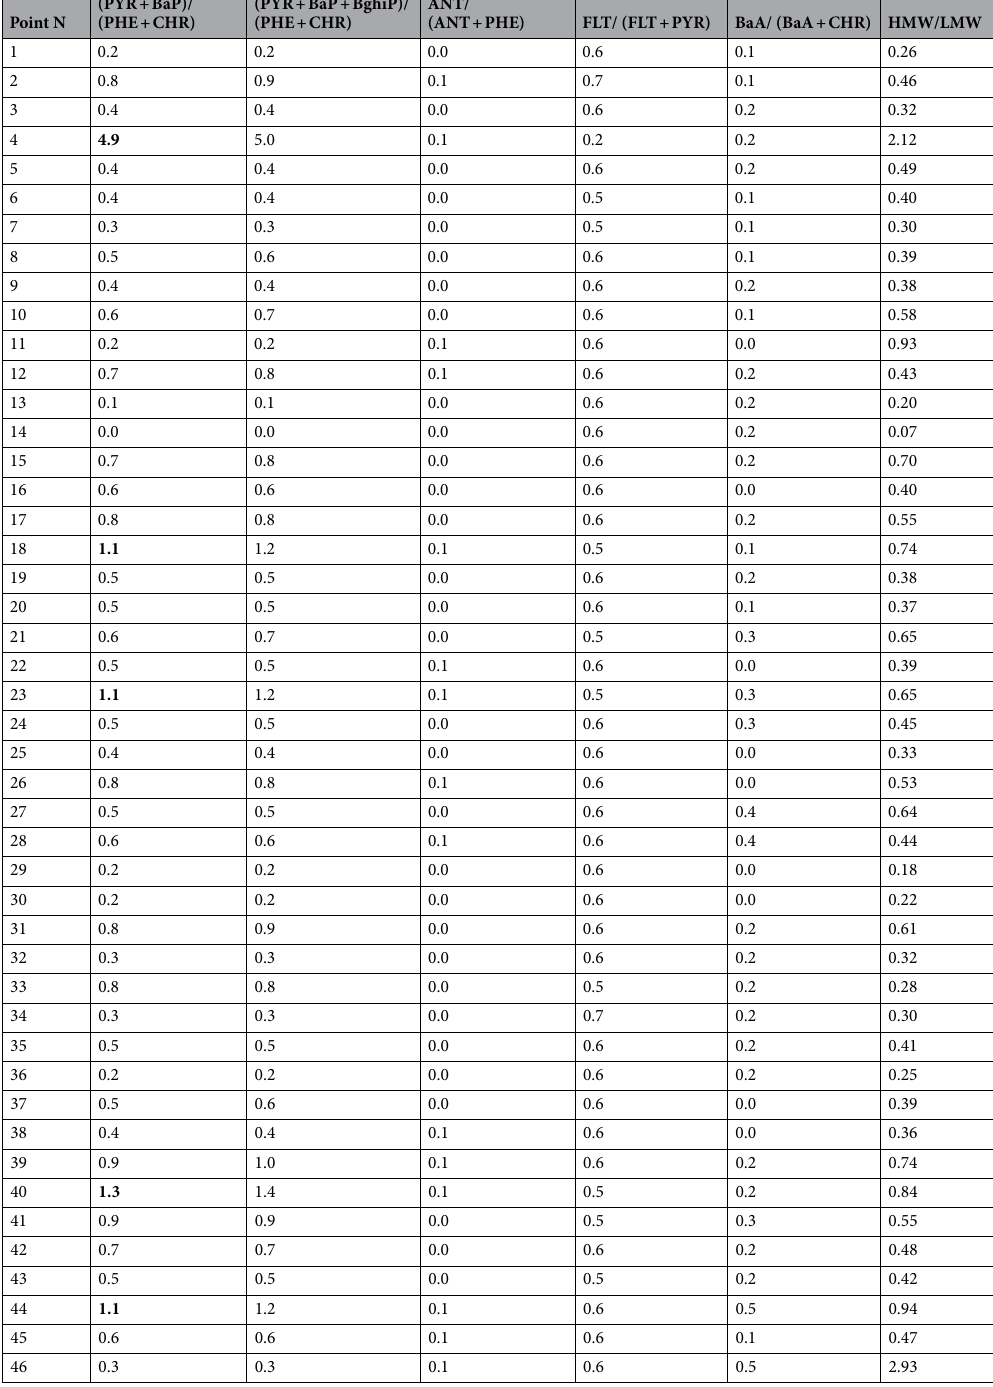
Table 2. The ratios PAH concentrations in the snow samples collected at different sampling